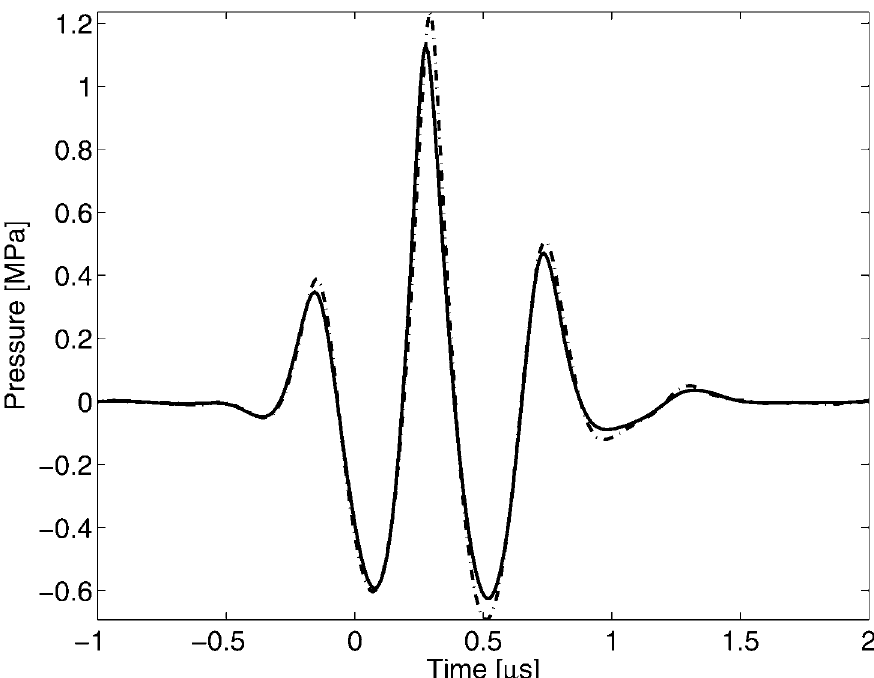
Figure 4. Comparison between the measured and numerically propagated acoustic field at the focal point, 69.0 mm away from the initial plane.